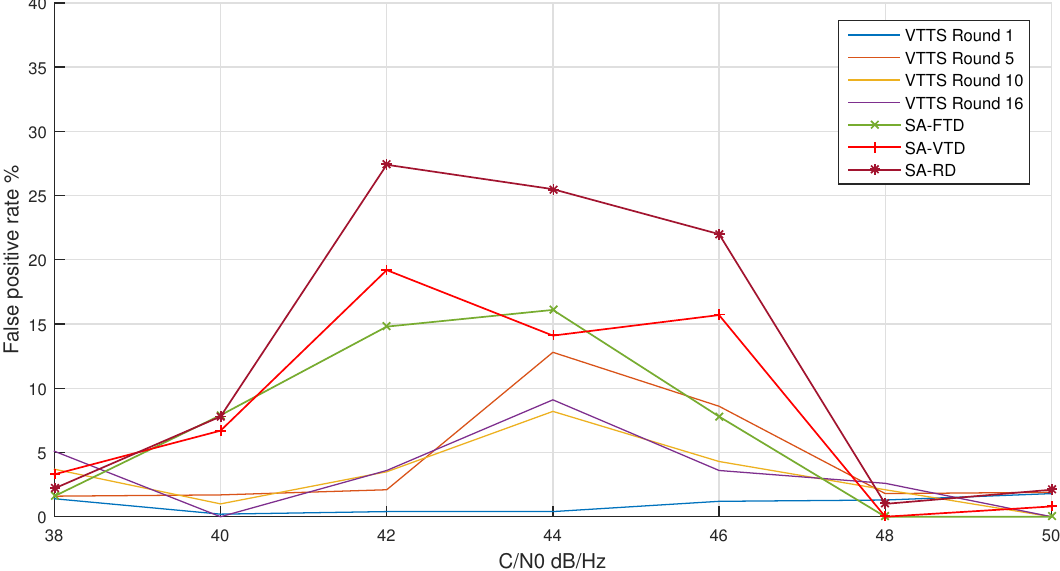
Figure 9. False-positive rate between the three SA versions and the VTTS acquisition for 1, 5, 10 and 16